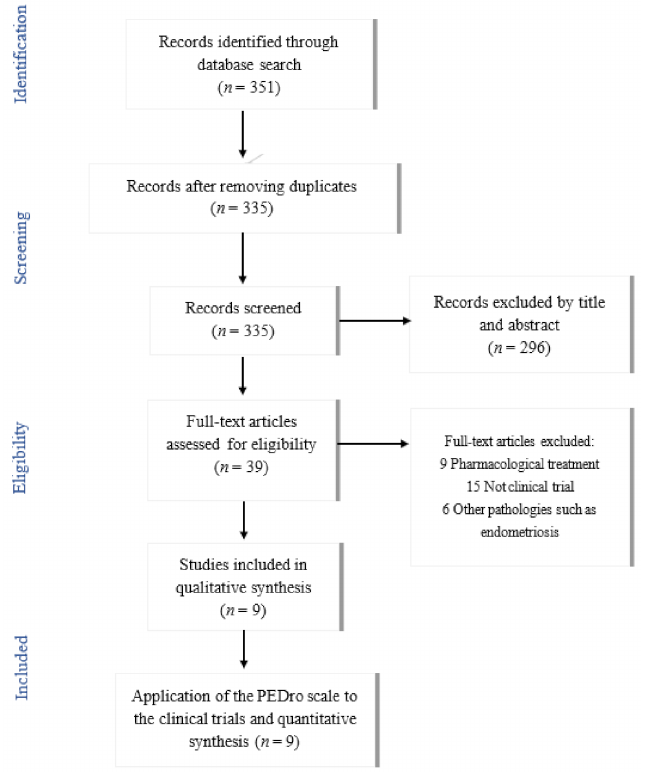
Figure 1. Flowchart of articles selection